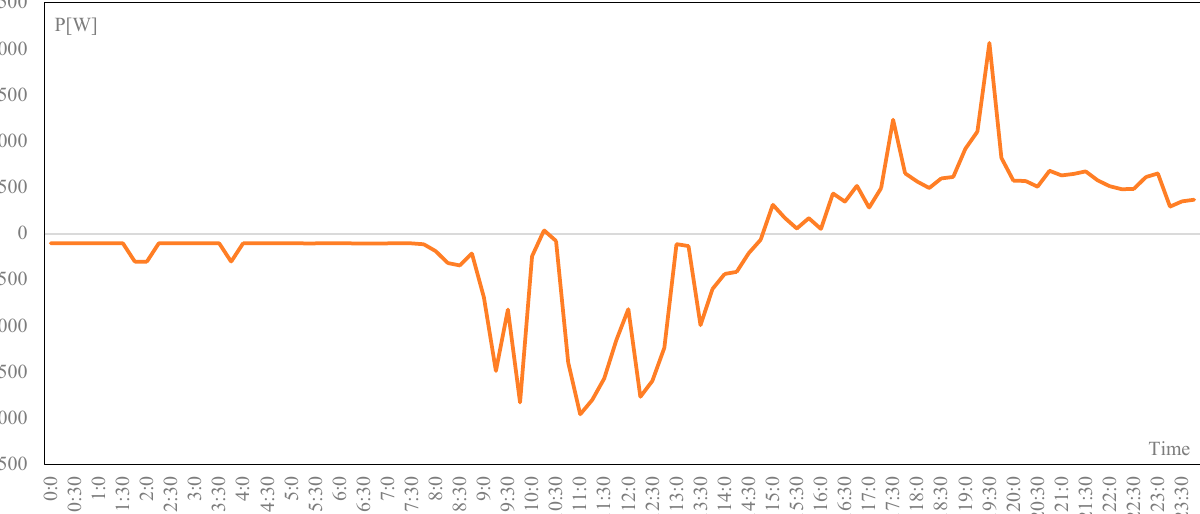
Figure 18. ESS power profile with flexibility service.